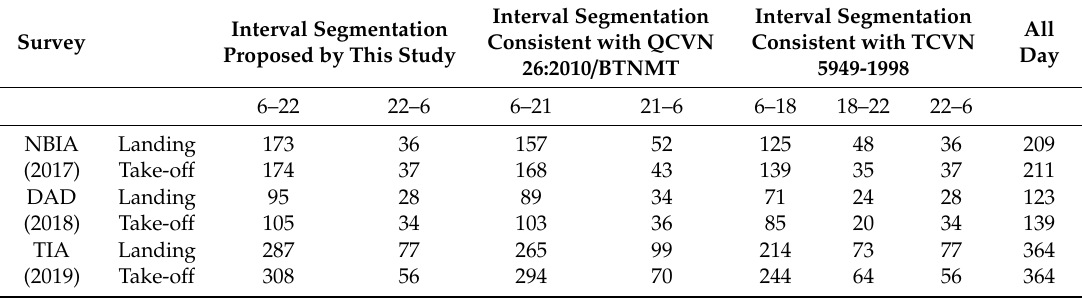
Table 11. Aircraft movement distribution at NBIA, DAD, and TIA in di ff erent time intervals.